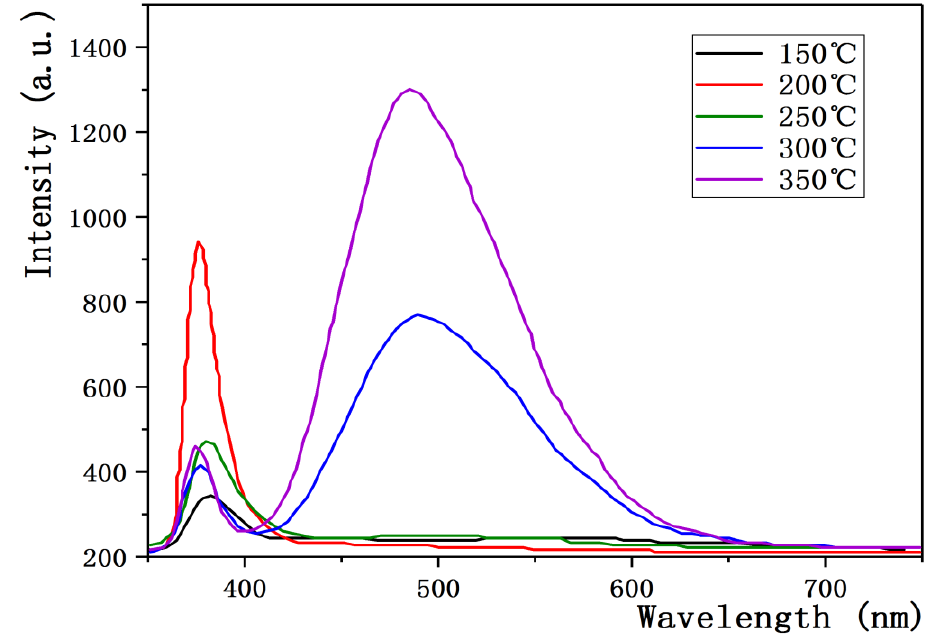
Figure 7. The photoluminescence spectra of ZnO thin films grown at different substrate temperatures [95].